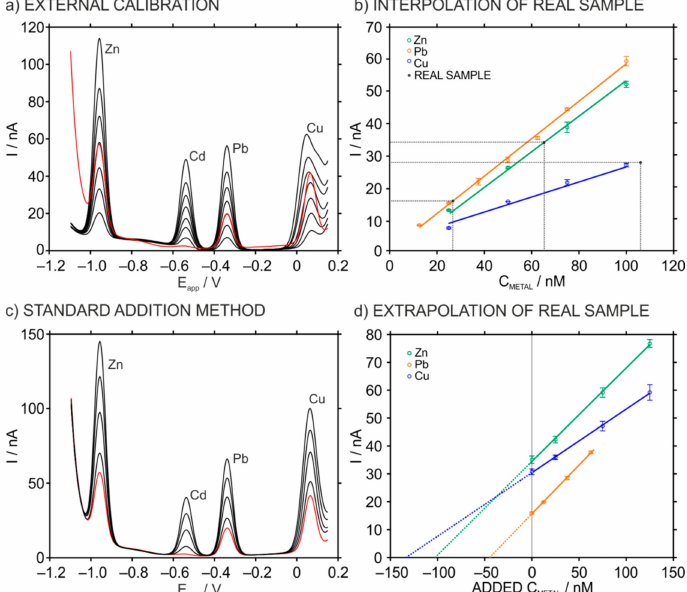
Figure 7. ( a ) Stripping voltammograms obtained at increasing concentrations of Zn 2+ , Cd 2+ , Pb 2+ and Cu 2+ in 0.01 M NaNO 3 / HNO 3 (pH 2.0) background solution. The red line indicates the voltammogram of one soil sample. ( b ) Corresponding calibration graphs after background correction of the voltammograms. The dashed arrows indicate the interpolation of the concentration for each metal in the sample. ( c ) Stripping voltammograms for the same sample (red line) and applying the standard addition method for calibration. ( d ) Corresponding calibration graphs after background correction showing the intercepts with the concentration axis for the extrapolation of the metals’